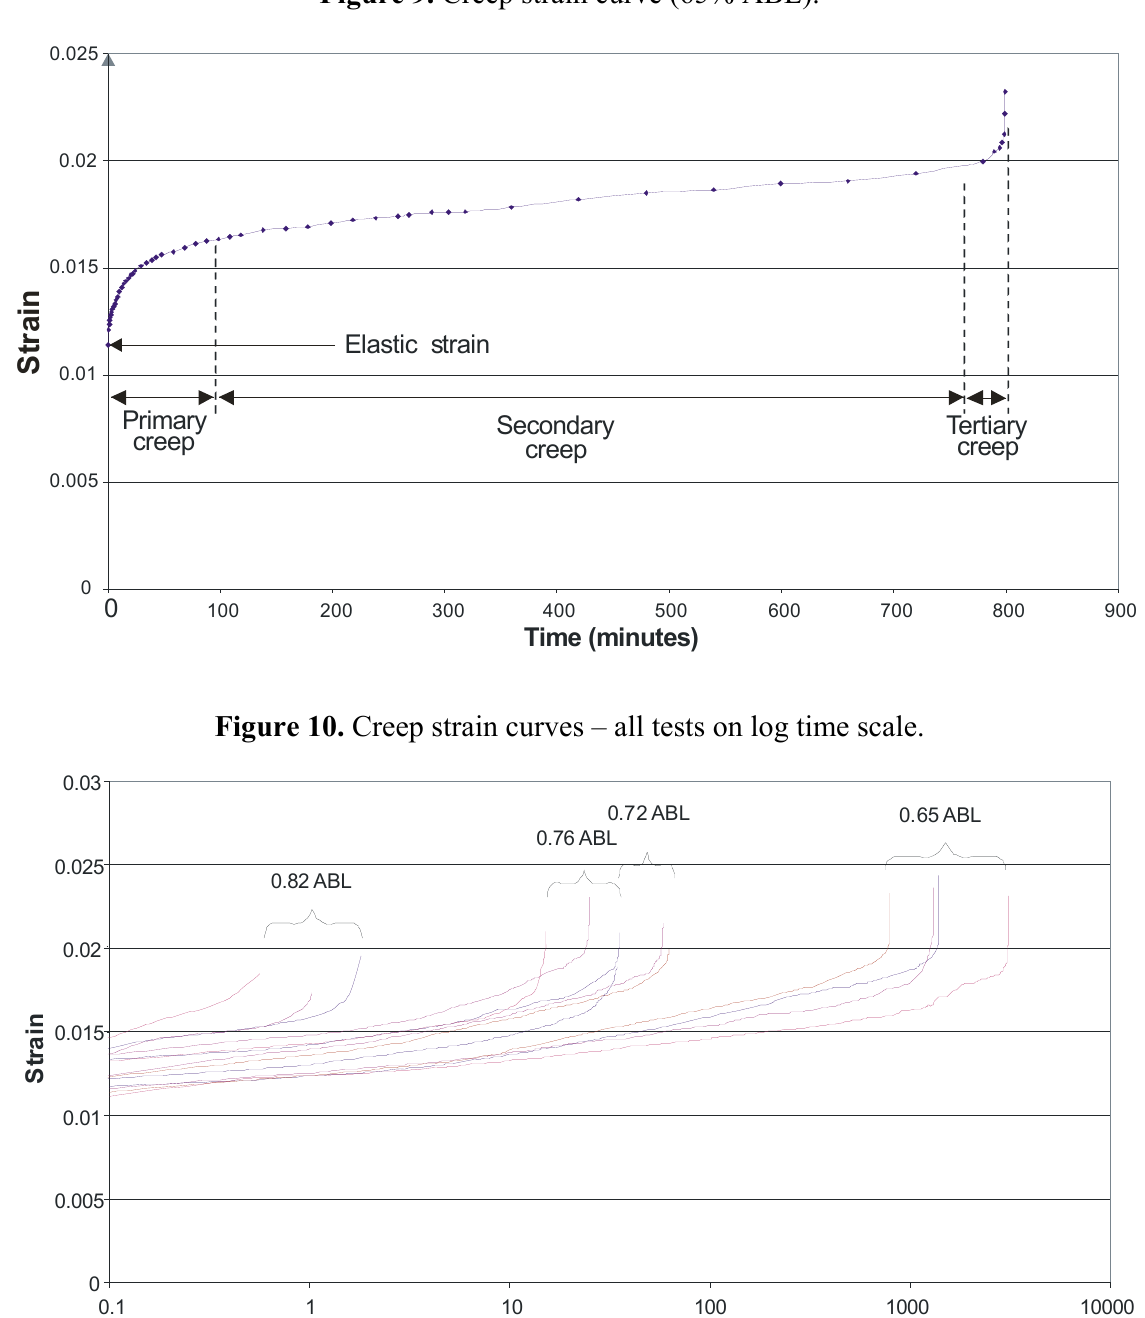
Figure 9. Creep strain curve (65% ABL).